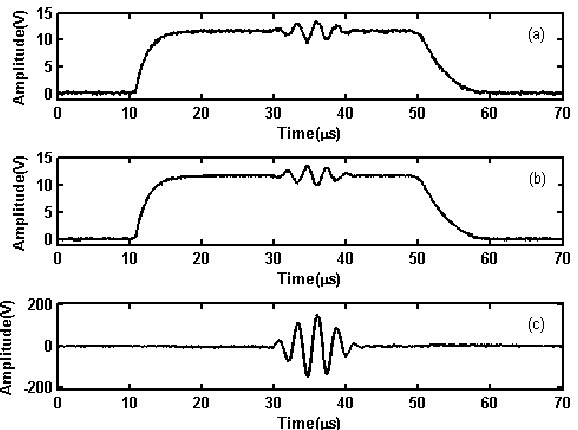
Figure 6. The driving signals of each branch and output signals of the power amplifier: ( a , b ) driving waveforms of two branches; ( c ) output waveforms of the output stage.